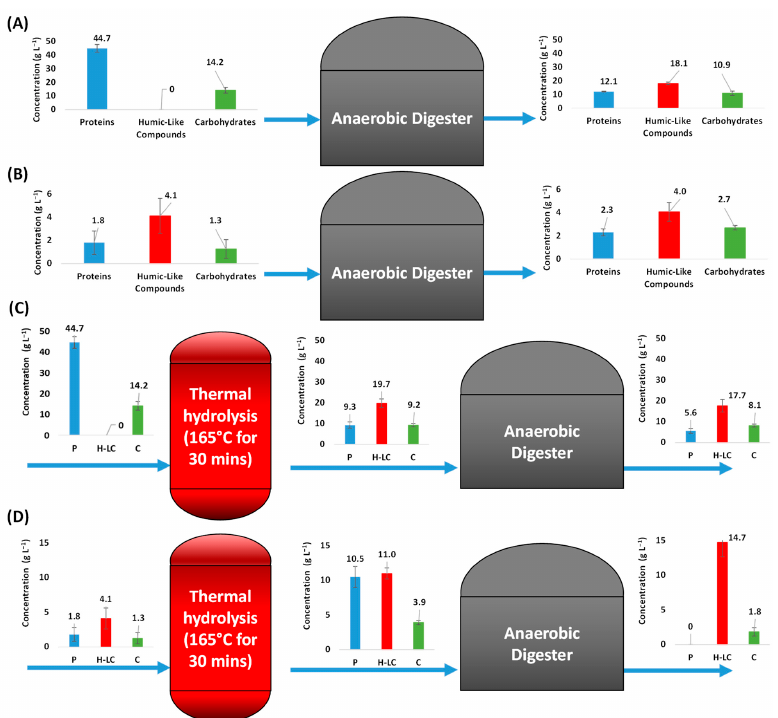
Figure 2. Concentration of ( A ) total and ( B ) Soluble proteins (P), carbohydrates (c), and humic-like compounds (H-LC) on inlet and outlet of anaerobic digester during CAD process and concentra- tion of ( C ) total and ( D ) soluble P, C, and H-LC in each stage of the TH-AD process. Dilution ef- fects due to steam addition were not considered. Error bars represent the standard deviation pre- senting samples taken at the steady state.